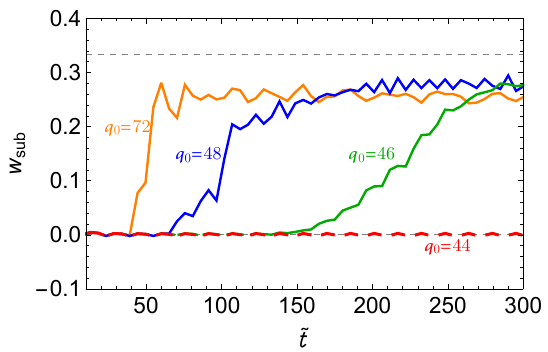
Figure 12 . Effective equation of state for different q 0 ’s in the sub-system σ and ψ . We fix m σ /σ 0 = 10 − 13 and λ = 6 . 5 × 10 − 24